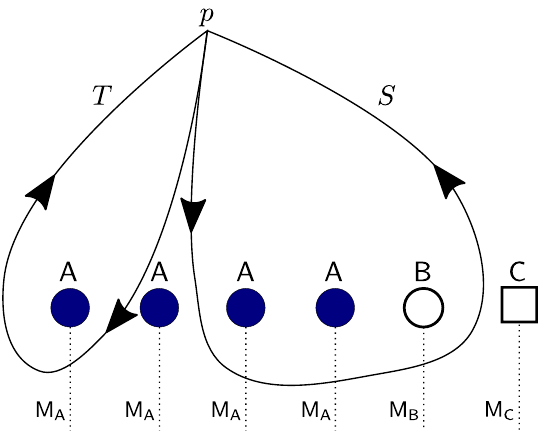
Figure 5. The paths that implement the monodromies S and T at the point p in the presence of the degenerations of the elliptic (cid:12)bration discussed in the text. The dotted lines indicate branch cuts. The monodromies indicated in the text are obtained by crossing the branch cut counterclockwise.